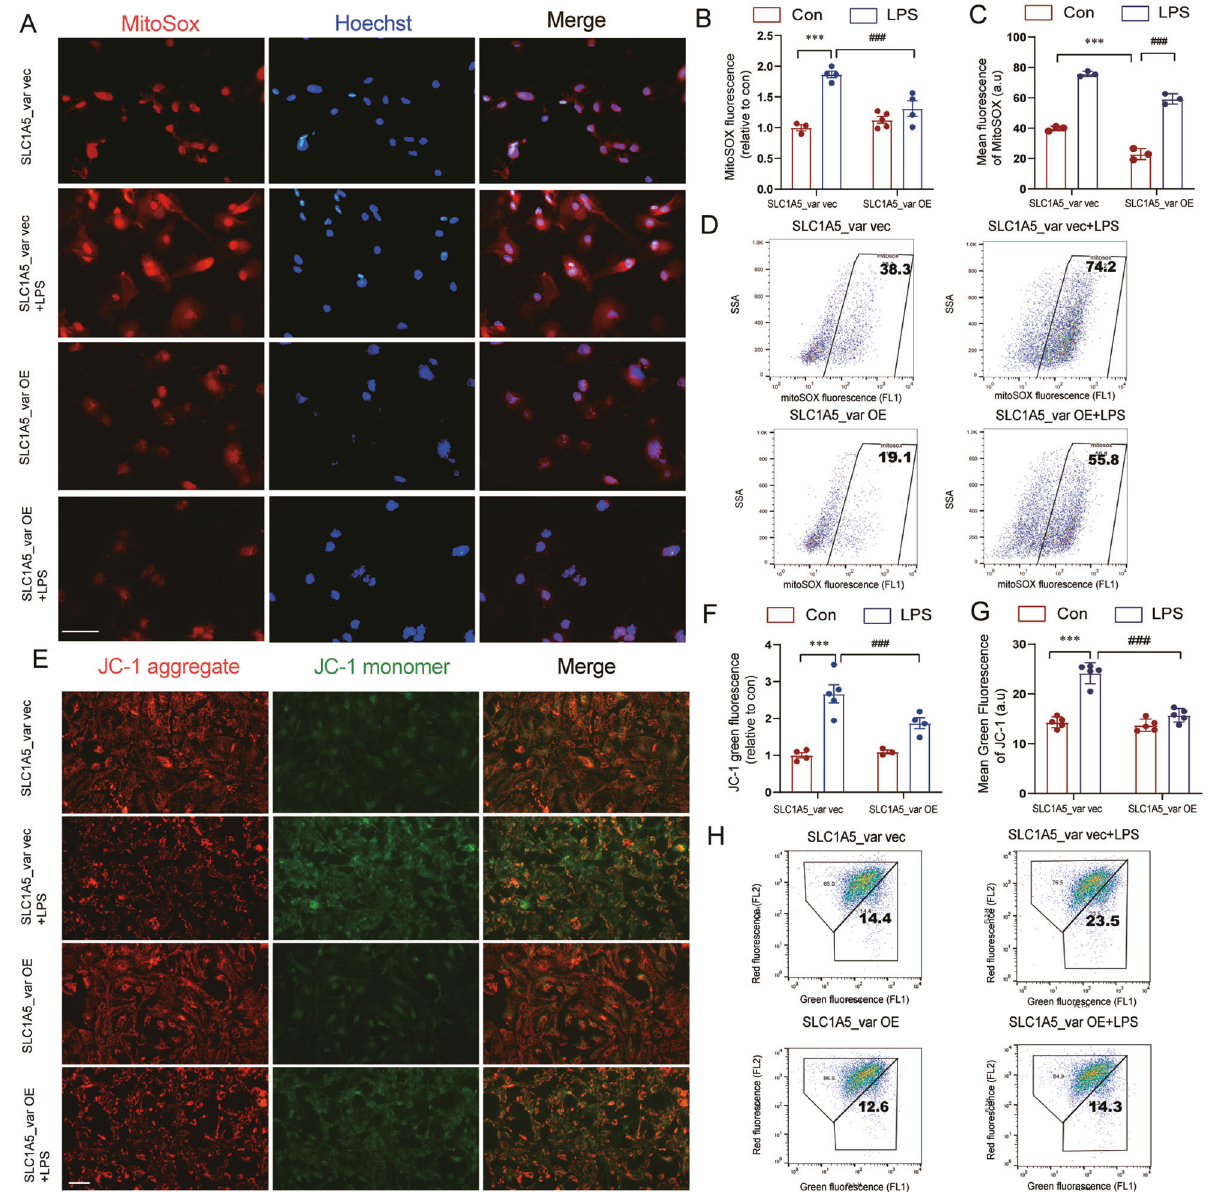
Fig. 3 SLC1A5_var attenuates the level of the mitochondrial ROS and membrane potential induced by LPS. Mitochondrial ROS accumulation was measured by the MitoSOX assay and monitored by fl uorescence microscopy ( A , B ) ( n = 3 – 5) and fl ow cytometry ( C , D ) ( n = 3). Scale bar: 40 μ m. Mitochondrial membrane potential (MMP) was measured by the JC-1 assay ( E , F ) ( n = 3 – 5) and monitored by fl ow cytometry ( H ) ( n = 5). Scale bar: 50 μ m. G The intensity of green fl uorescence cells was analyzed. Data are shown as the mean ± S.E.M. *** P < 0.001 vs control, ### P < 0.001 vs LPS group, two-way ANOVA followed by Tukey ’ s post hoc